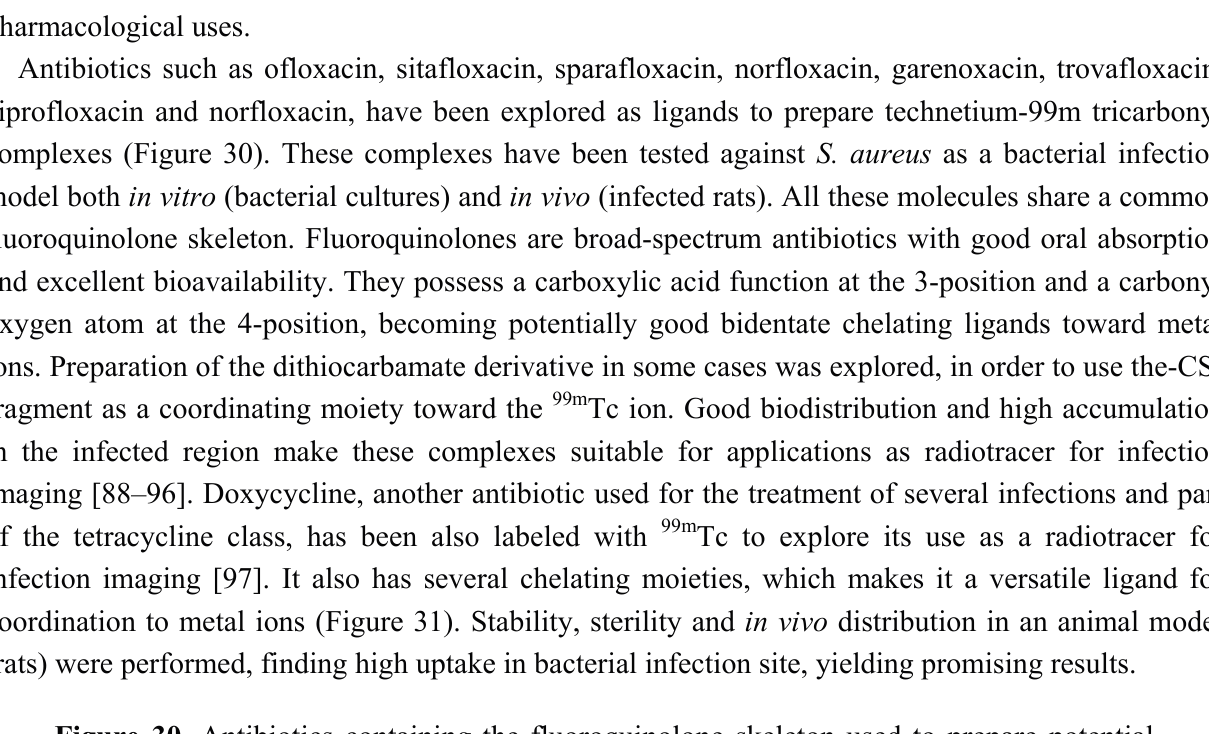
Figure 30. Antibiotics containing the fluoroquinolone skeleton used to prepare potential infection radiotracer imaging agents: (i) Oxoflacin; (ii) Sitafloxacin; (iii) Sparafloxacin; (iv) Norfloxacin; (v) Garenoxacin; (vi) Trovafloxacin; (vii) Ciprofloxacin. In the box, chelating modes of fluoroquinolones and its dicarbamathe derivatives are shown for